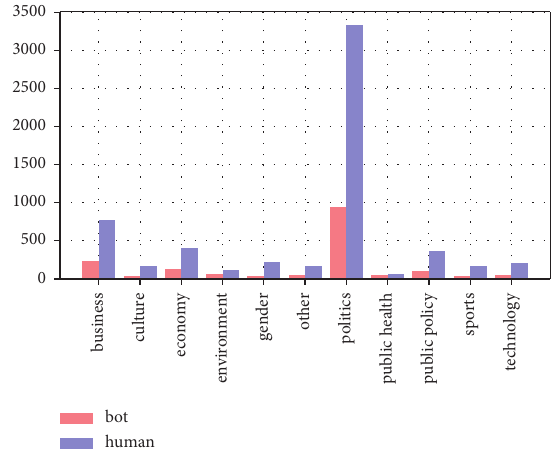
Figure 4: Distribution of bots in primary communication for 121 The New York Times reports’